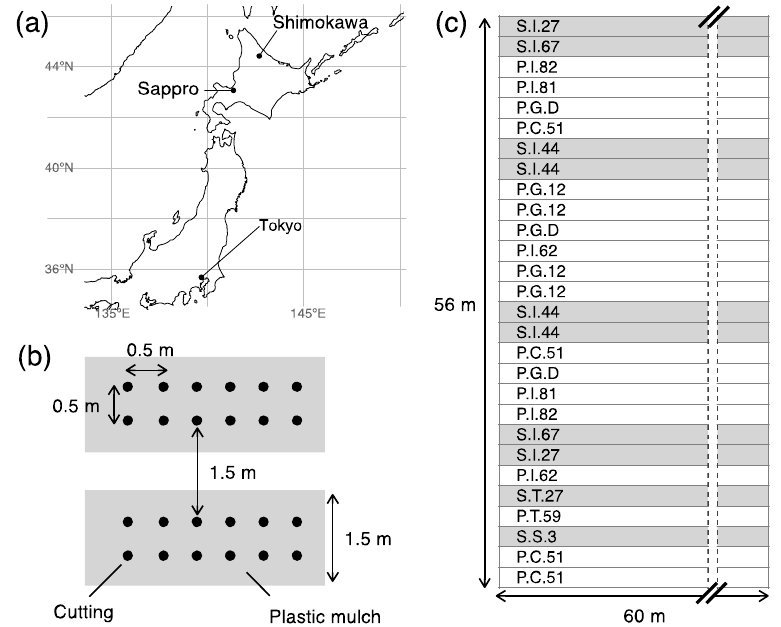
Figure 1. Study site and experimental design. Location of the study site in Shimokawa town, Japan ( a ), planting design with double-row system ( b ), and arrangement of willow clones in the 28 rows ( c ). Clone names beginning with “P” (white rows) and “S” (gray rows) in panel ( c ) represent Salix pet-susu and S. sachalinensis , respectively.